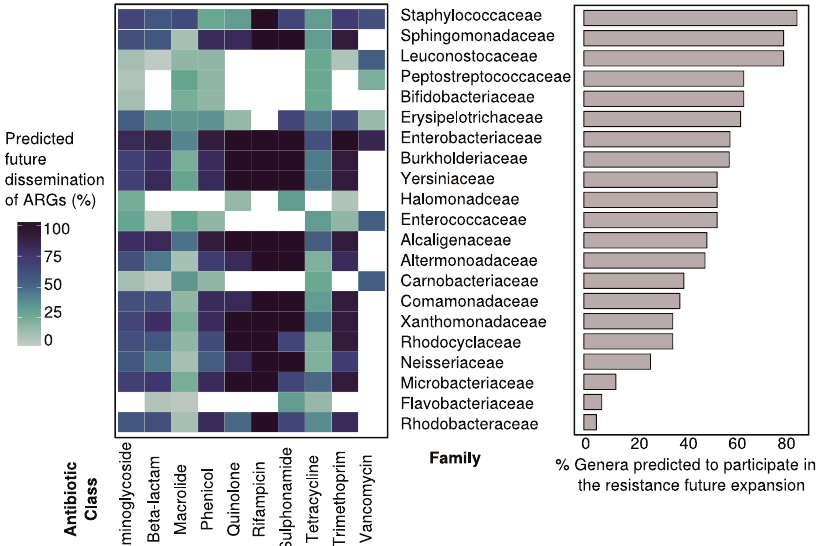
Fig. 4 Predicted transfer of antibiotic resistance genes (ARGs) to new bacterial families. Heatmap shows percents of transferable ARGs by affected antibiotic class with potential for future dissemination to indicated bacterial families. Barchart shows percents of genera within each family that may receive new ARGs based on their current association with a relevant mobile genetic element. Source data are provided in Supplementary Data 1, 3, 5, 10, and